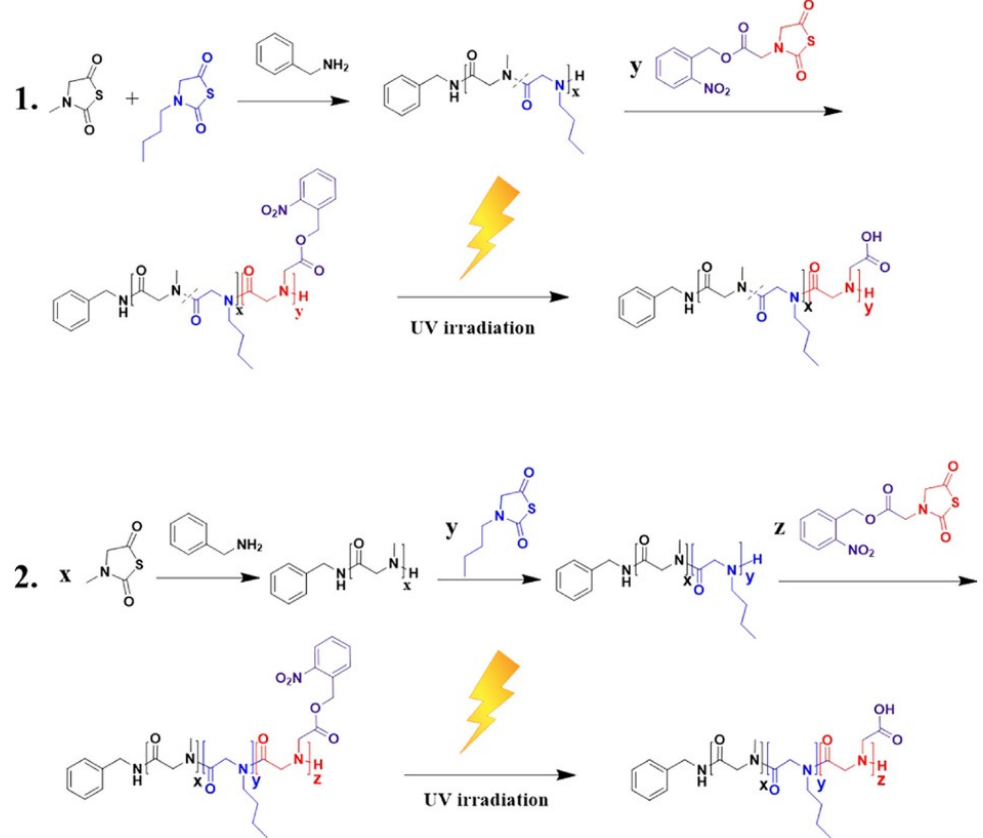
Figure 6. ( 1 ) Synthesis of diblock polypeptoids P(Sar- r -NBG)- b -PNB and the photocleavage of the Nitrobenzyl Group after irradiation with 254 nm UV light and ( 2 ) Synthesis of triblock polypeptoids PSar- b -PNBG- b -PNB and the photocleavage of the Nitrobenzyl Group after irradiation with 254 nm UV light (Adapted from ref. [62]. Copyright 2020, American Chemical Society).